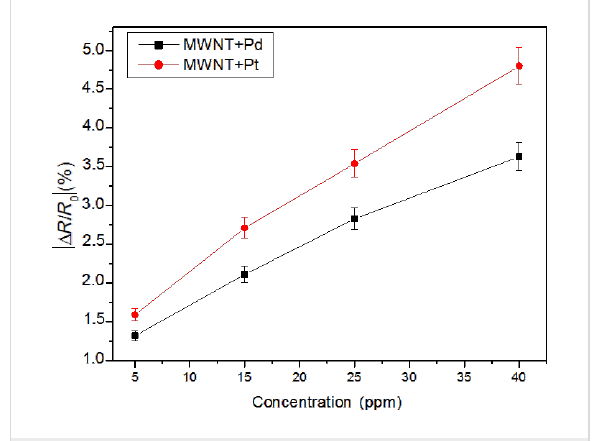
Figure 7: Calibration curves of Pd– MWCNT and Pt–MWCNT sensors to NO 2 .